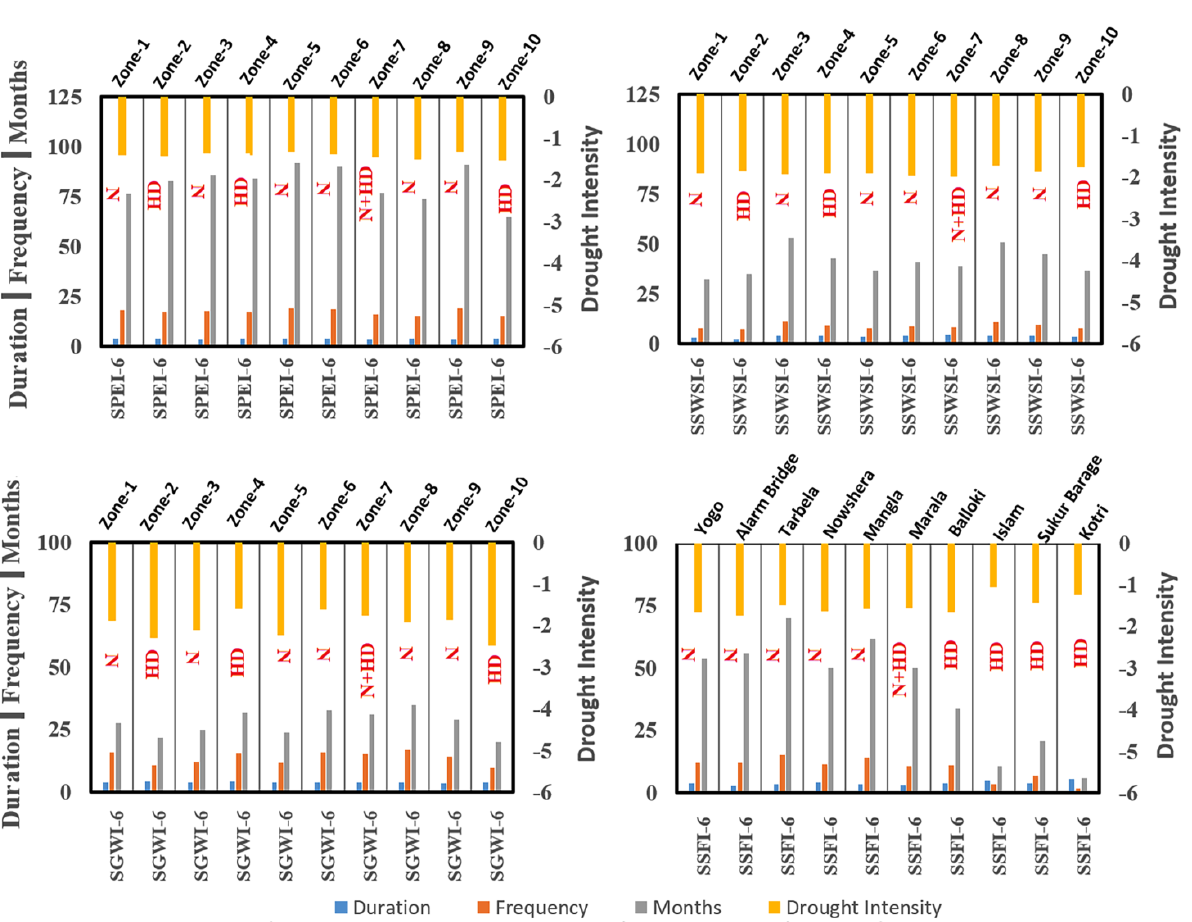
ble for these regions.